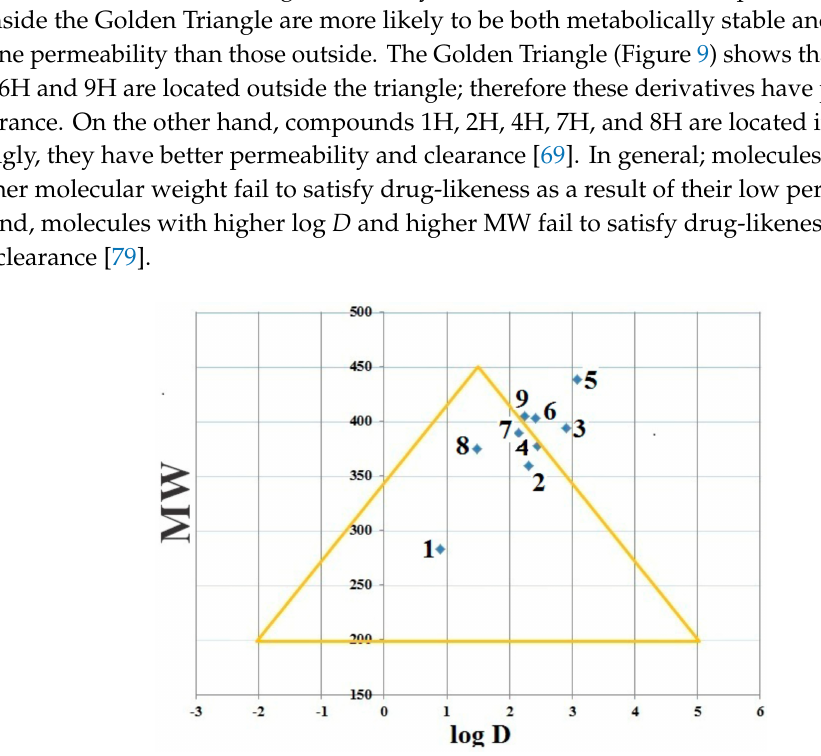
Figure 9. Golden triangle of DHIPP, 1–9 compounds 1H–9H